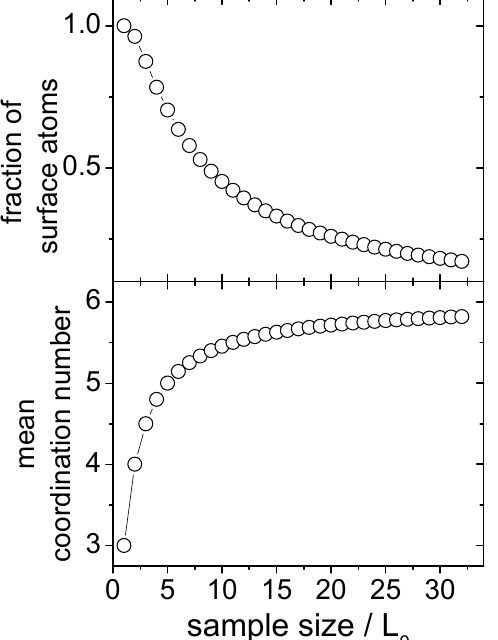
Figure 2. Fraction of surface atoms and mean coordination number in a primitive cubic sample (L 0 is the atom bond distance, see text for comments).